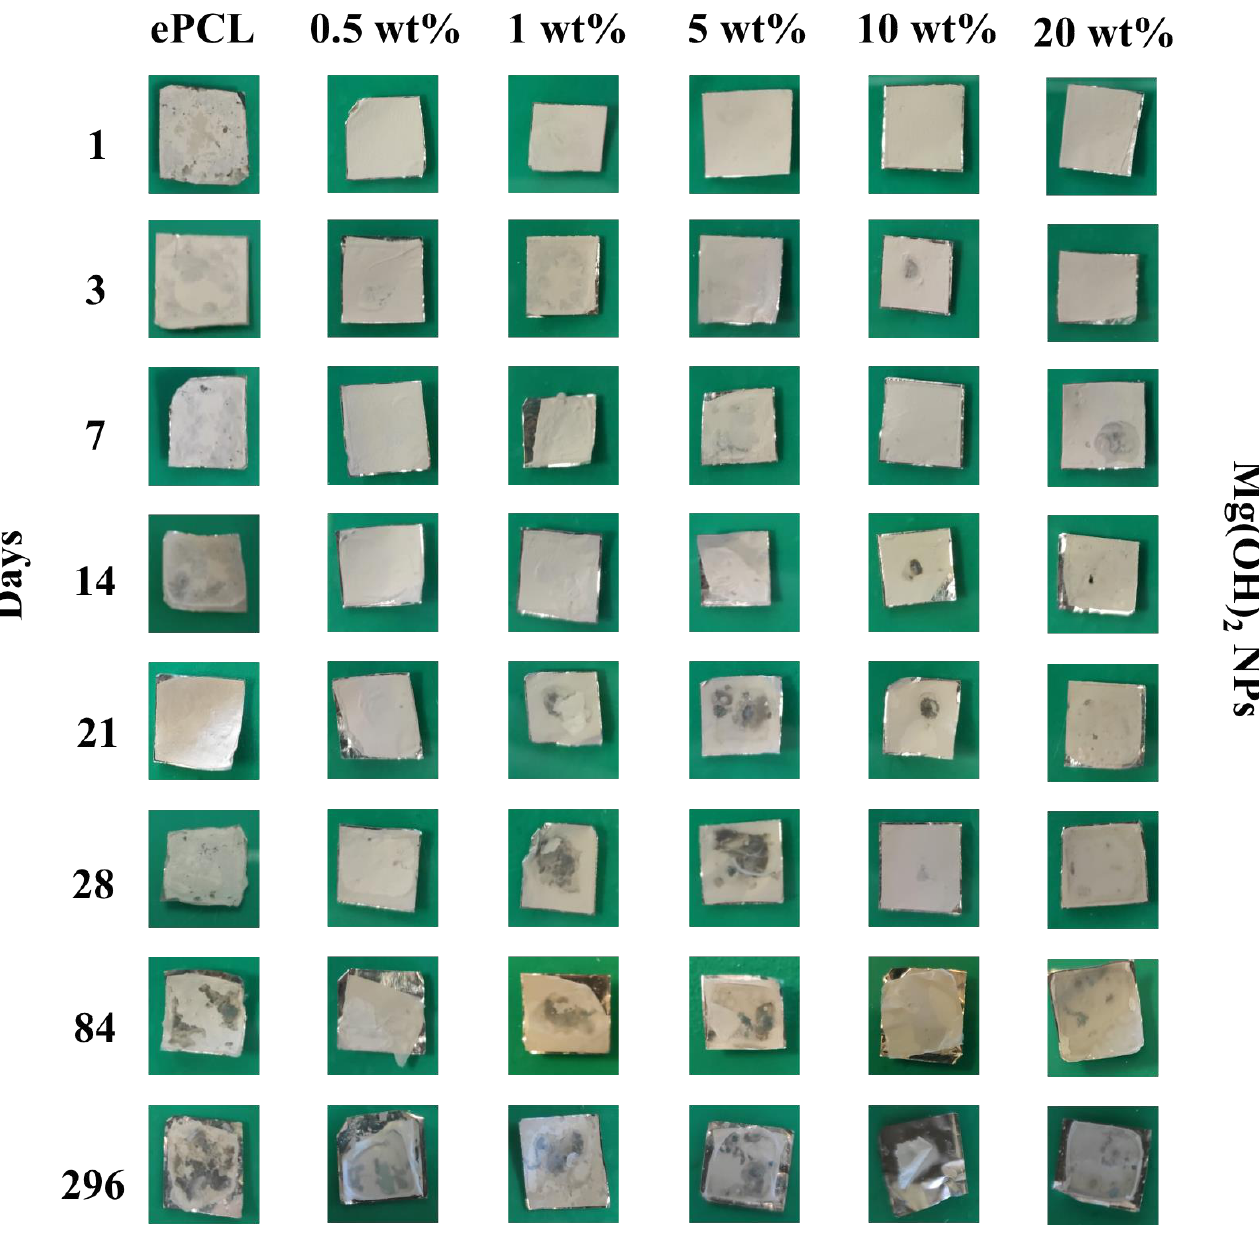
Figure 2. Photos of ePCL and ePCL + Mg(OH) 2 NPs at different concentrations and different immersion times.